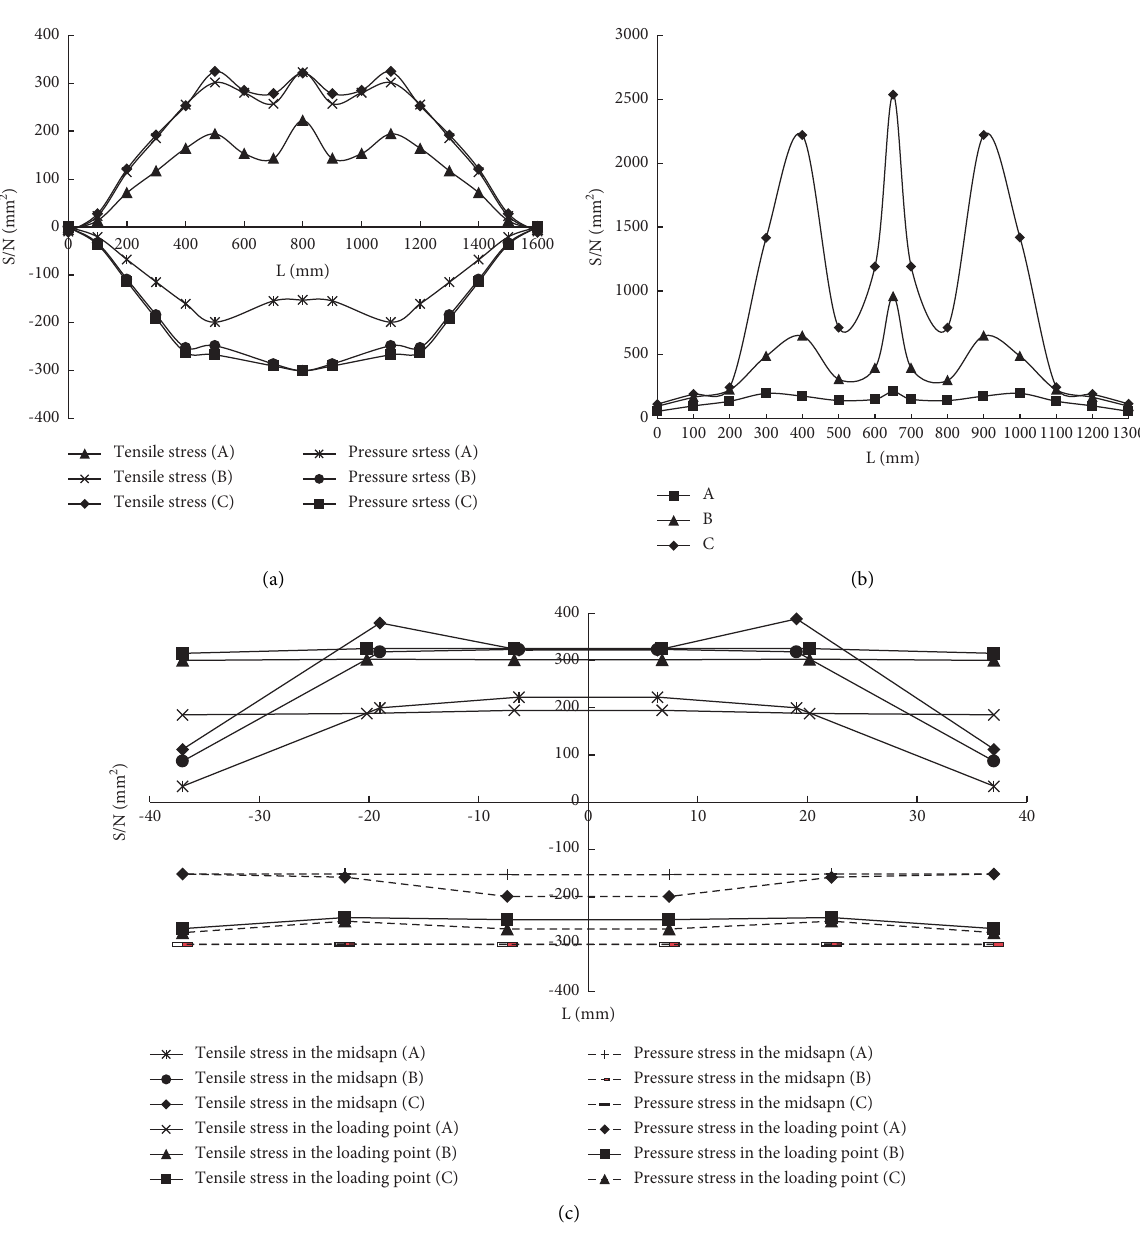
Figure 11: Stress curves. (a) Stress along steel beam length. (b) Stress along CFRP sheet’s length. (c) Stress along steel beam